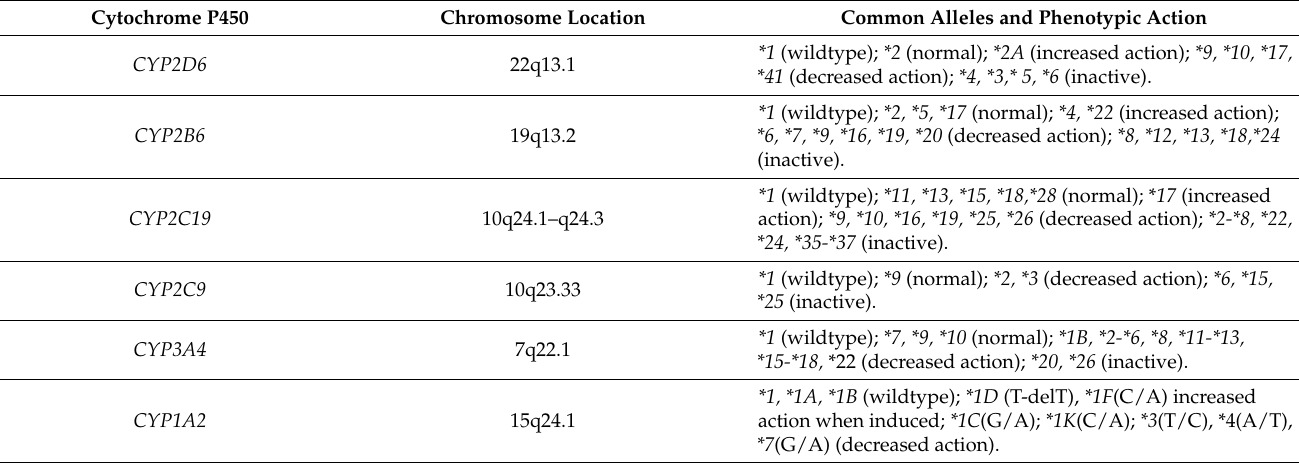
Table A1. Chromosome location for genes producing cytochrome P450 (CYP) enzymes, their common polymorphisms and phenotypic activity [38];